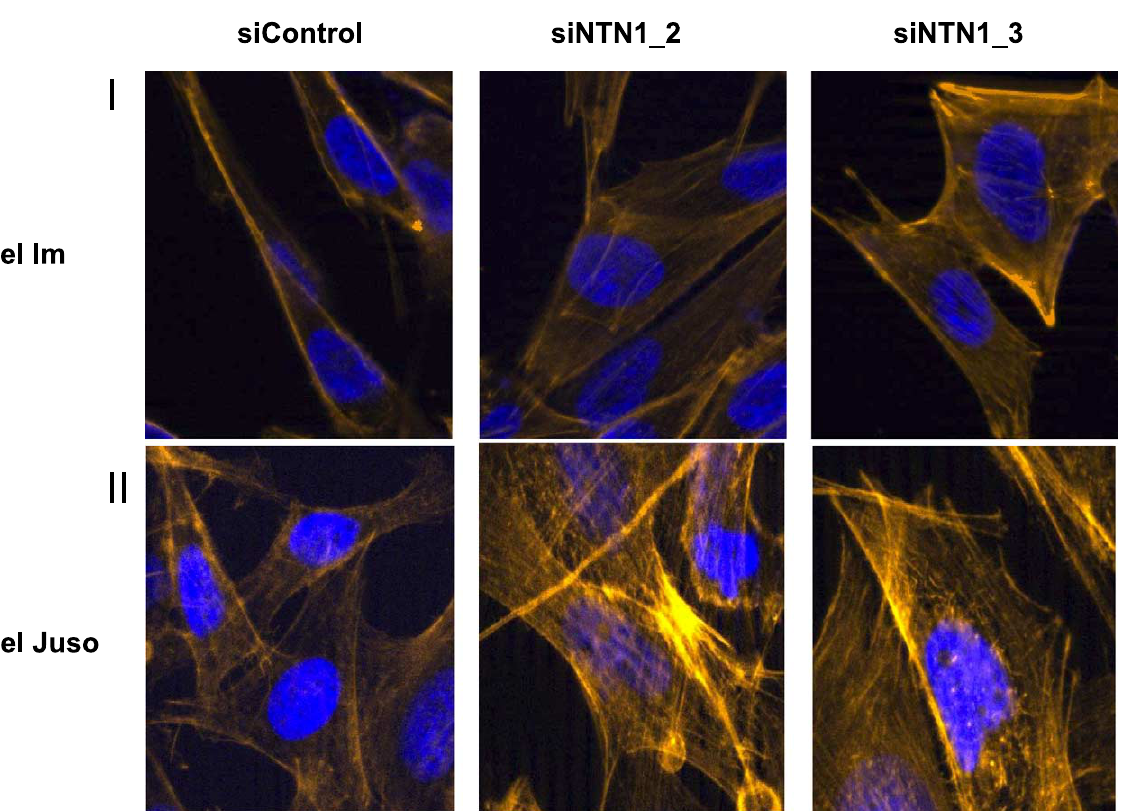
Fig. 5. Cytoskeletal changes after downregulation of Netrin-1 expression. Cells ((I) Mel Im and (II) Mel Juso) were treated with siRNAs against Netrin-1 (siNTN1_2, siNTN1_3) or control siRNA (siControl) and the cytoskeleton was stained with Phalloidin–Rhodamine. Strong changes were observed comparing siNetrin with siControl treated